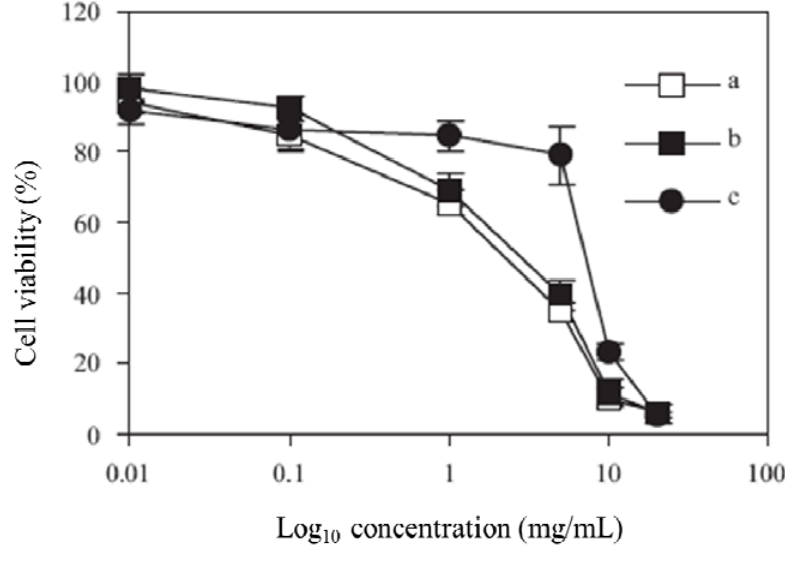
Figure 3. Viability of Caco-2 cells after incubation with polymer 1 ( a ), polymer 2 ( b ), and polymer 3 ( c ), at 37 °C for 4